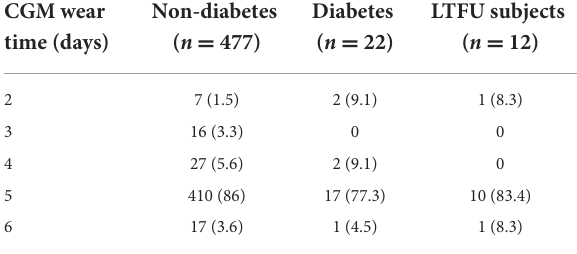
The final number of subjects with at least 2 days of monitoring (the minimum required for their data to be included in analyses) was 499. They were older (mean age 47 ± 14 years), mean BMI of 27.8 ± 5.0 kg/m 2 and 13% had metabolic syndrome. Mean FPG and HbA1c of this subsample was 88 ± 10 mg/dL and 5.3 ± 0.3%, respectively. CGM wear time data are shown in Table